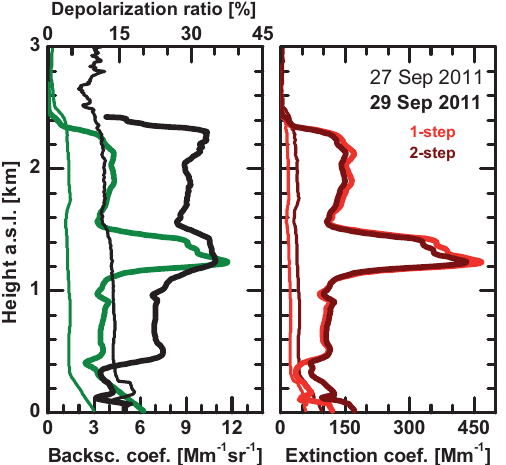
Figure 1. (Left) The 532nm particle backscatter coefficient (green) and particle linear depolarization ratio (black) as a function of height above sea level (a.s.l.) and (right) dust extinction coeffi- cients computed by means of the one-step and two-step methods (Mamouri and Ansmann, 2014). A major dust outbreak from the Middle East deserts was observed with the CUT lidar at Limassol, Cyprus, on 29 September 2011, whereas fine-mode soil dust, proba- bly injected during biomass burning events in Turkey, was observed on 27 September 2011. The data analysis is explained in detail by Mamouri and Ansmann